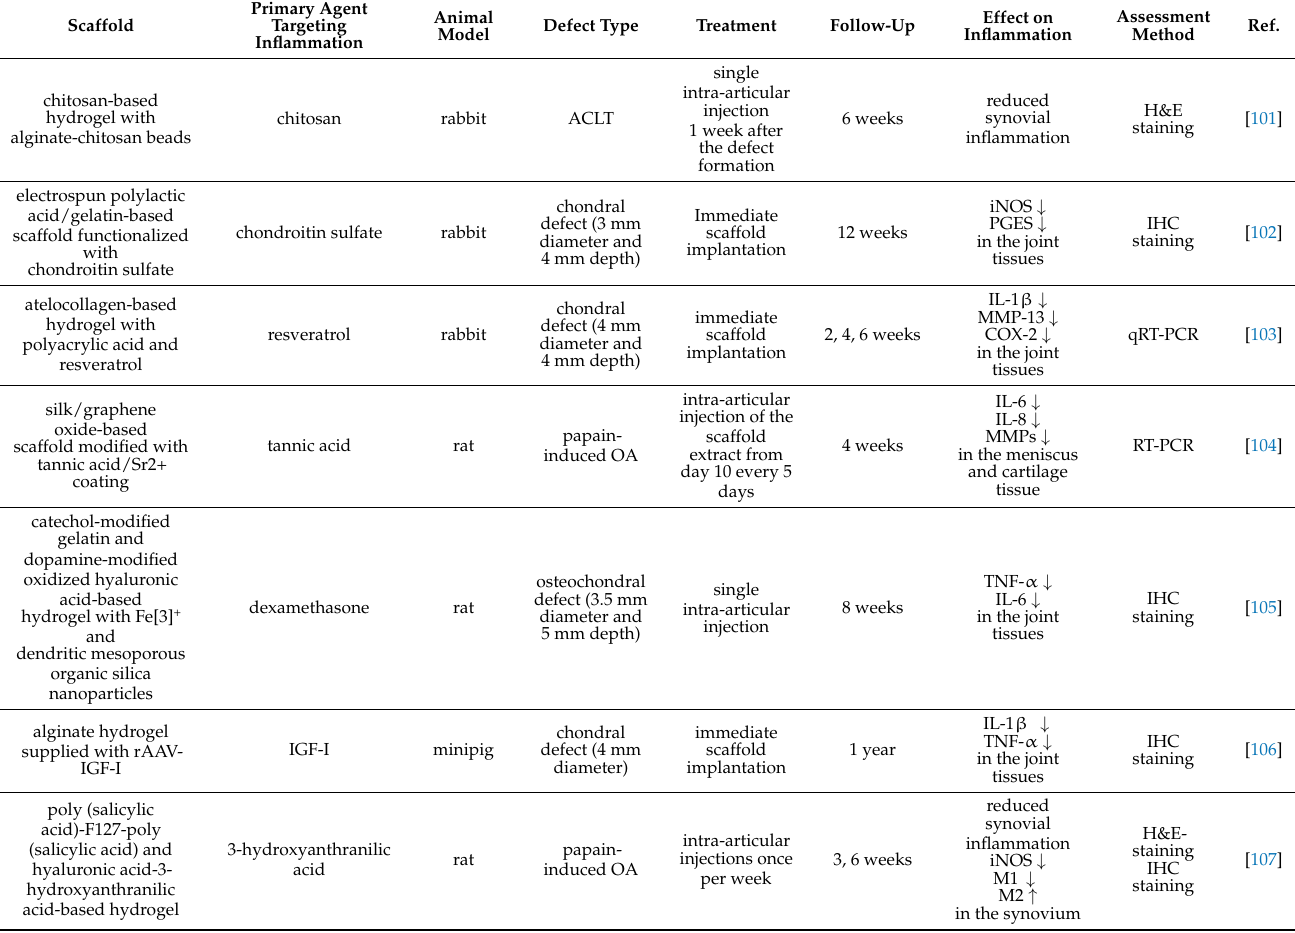
Table 1. Inflammation-targeting scaffolds for treating cartilage defects in